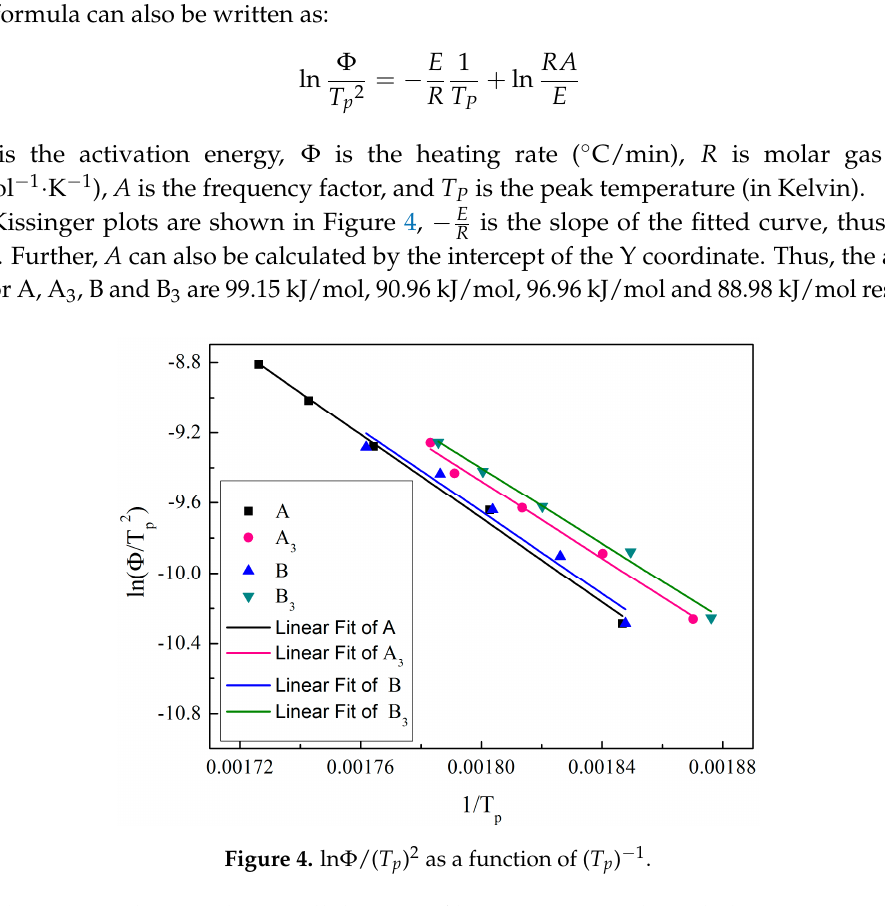
Figure 4. ln Φ /( T p ) 2 as a function of ( T p ) − 1 .